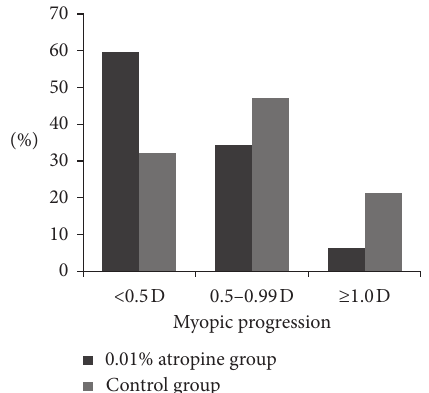
Figure 4: Distribution of myopic progression in the atropine and control groups at 6-month follow-up. In the atropine group, 59.4%, 34.3%, and 6.3% participants progressed by < 0.5D, 0.5–0.99D, and ≥ 1.0D, respectively. In comparison, 31.9%, 46.8%, and 21.3% participants in the control group progressed by < 0.5D, 0.5–0.99D, and ≥ 1.0 D, respectively. D �